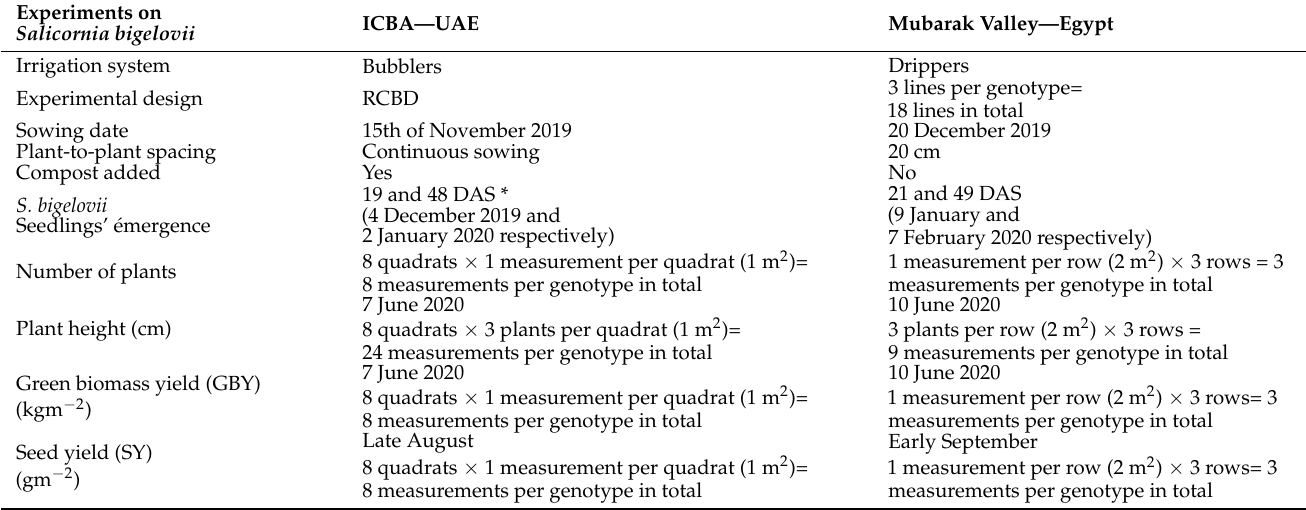
Table 1. Details of the S. bigelovii experiments implemented at ICBA in Dubai in the United Arab Emirates and Mubarak Valley in Marsa Alam in Egypt.